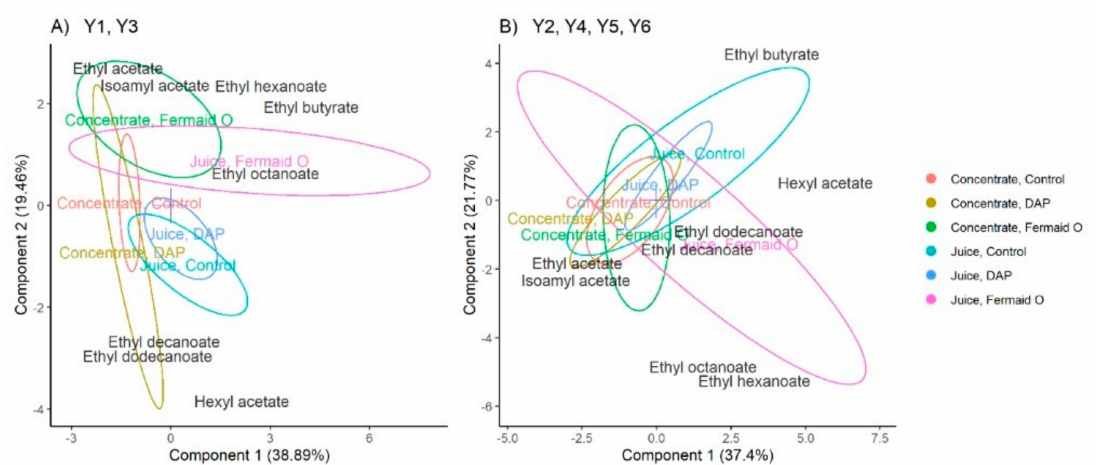
Figure 4. PLS-DA biplots of volatile ester production in cider samples. ( A ) S. bayanus yeasts; ( B ) S. cerevisiae yeasts. Colors correspond to the combinations of juice type and nutritional supplement. Ellipses indicate confidence region at 0.95 level. The number in parenthesis shows variance captured by the